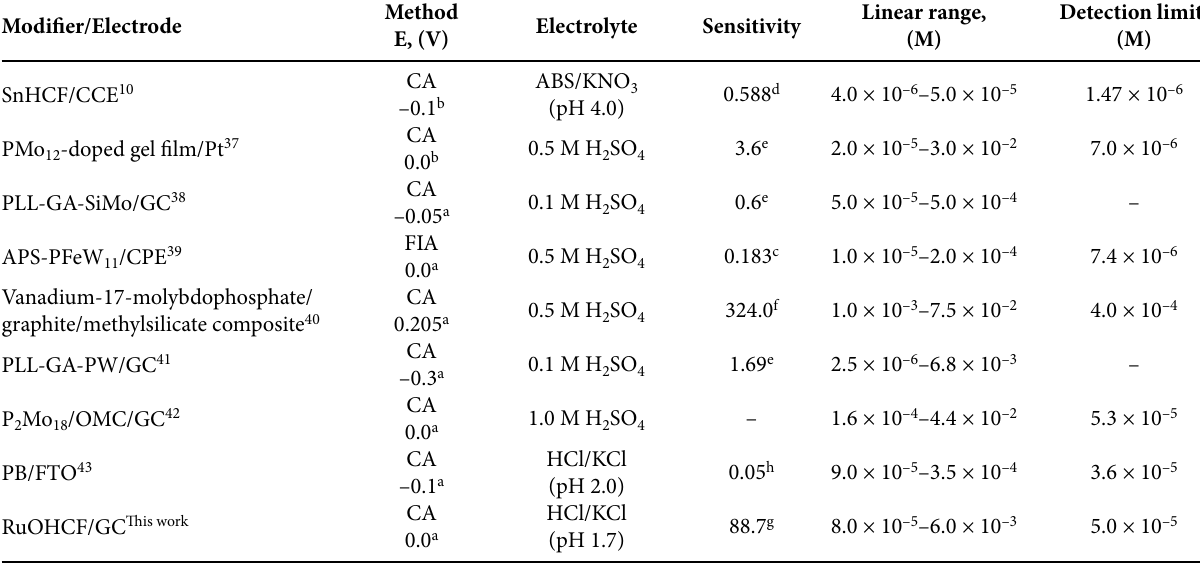
Table 1. Comparison of the operational characteristics of amperometric sensors for H 2 O 2 detection in strongly acidic medium with the achieved in the present work.